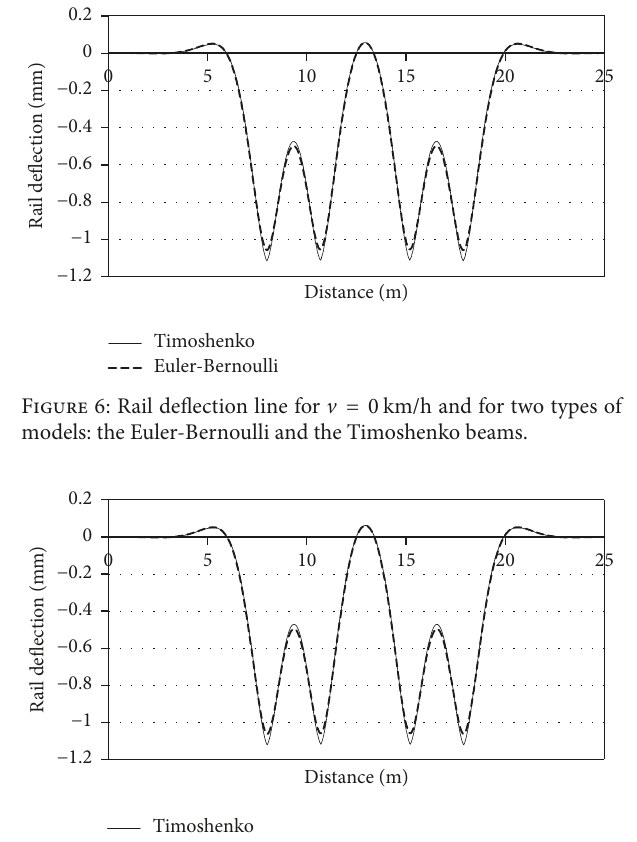
3000 km/h, the dynamic factor can be estimated around 0.5 in both